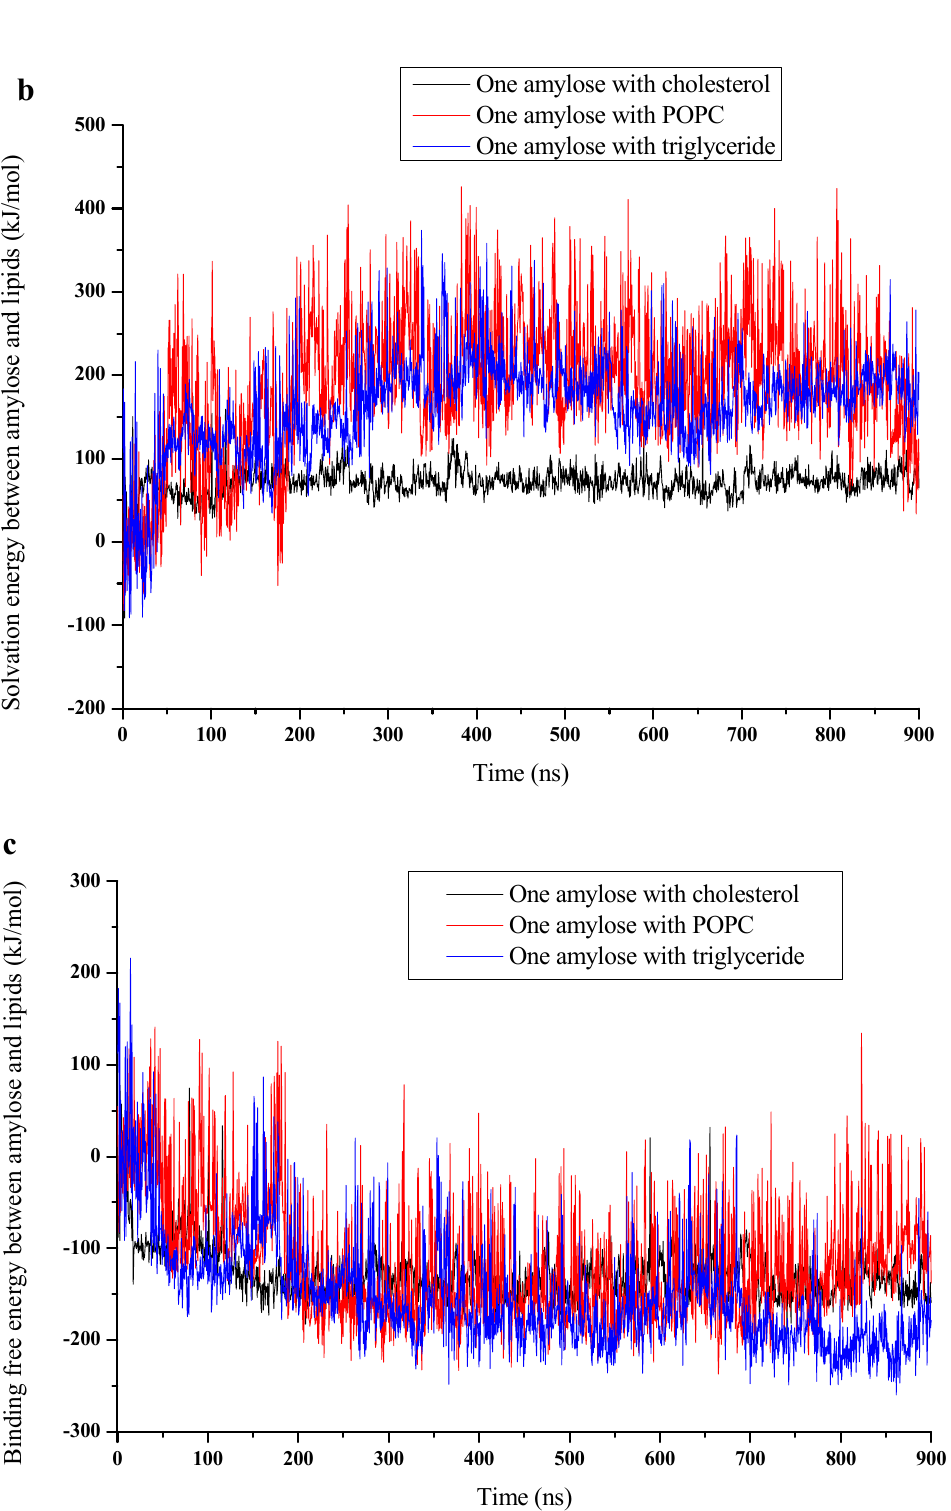
Figure 5. MM potential energy ( a ), solvation energy ( b ) and binding free energy ( c ) for amylose ‐ cholesterol complex (black line), amylose ‐ POPC complex (red line) and amylose ‐ triglyceride complex (blue line). Binding free energy is the sum of potential and solvation free energies. Figure 5c shows the evolution of binding free energy between amylose and lipid molecules for cholesterol, POPC and triglyceride, respectively. In these calculations, the initial distance of separation between the centers of mass of the amylose and the lipid was 2 nm. As